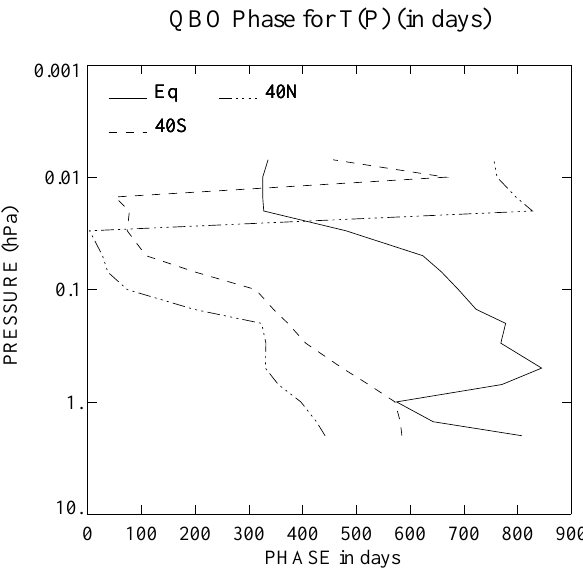
Fig. 11. Profiles of the relative phases for the QBO terms at selected